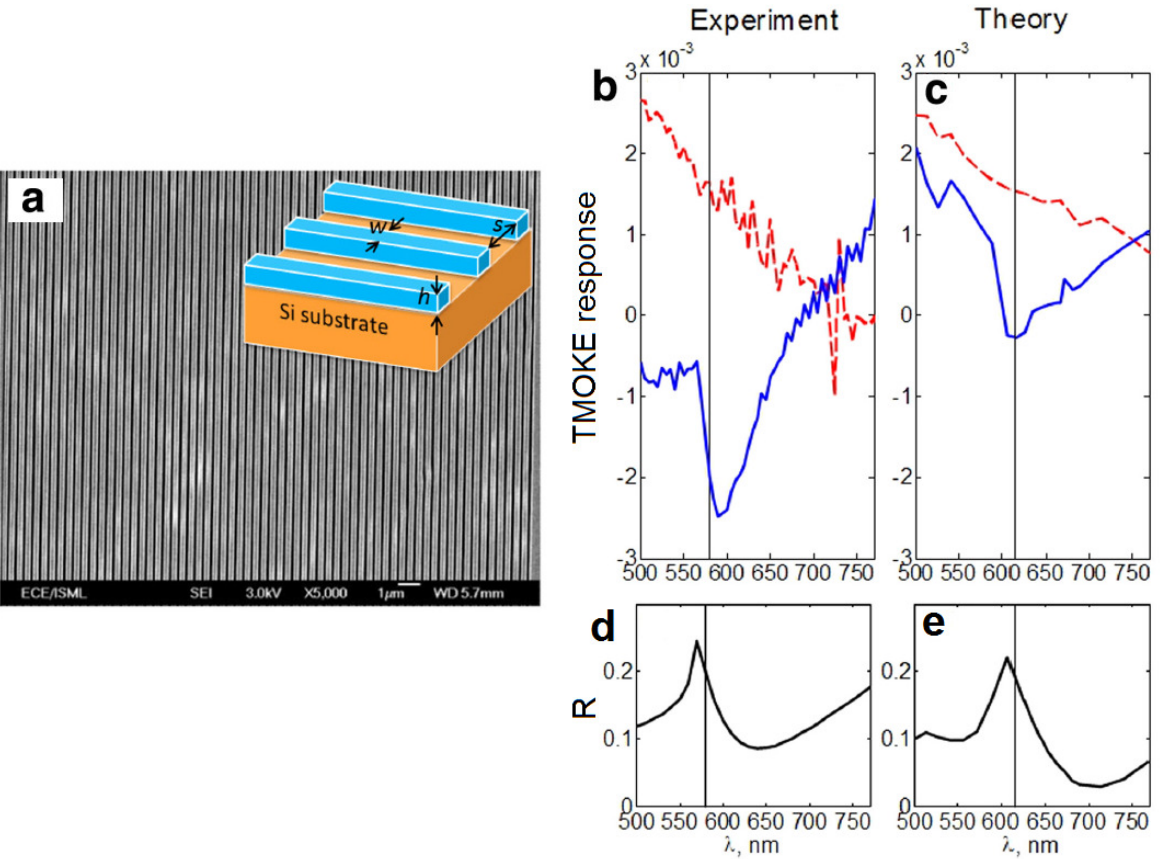
Figure 3. ( a ) Scanning electron micrograph and schematic of the Permalloy grating (one-dimensional magnonic crystal). The total area of the grating is 0 . 5 × 0 . 5 cm 2 , h = 100 nm, w = 264 nm, and s = 113 nm. The thickness of the Si substrate is 0 . 8 mm; ( b ) Measured and ( c ) Simulated TMOKE response of the 100 nm-thick reference Permalloy film (dashed line) and Permalloy grating (solid line); Measured ( d ) and ( e ) Simulated reflectivity spectra of the Permalloy grating. The vertical straight solid line denotes the Fano resonance wavelengths. Reproduced from [57] with permission by AIP Publishing LLC, Copyright